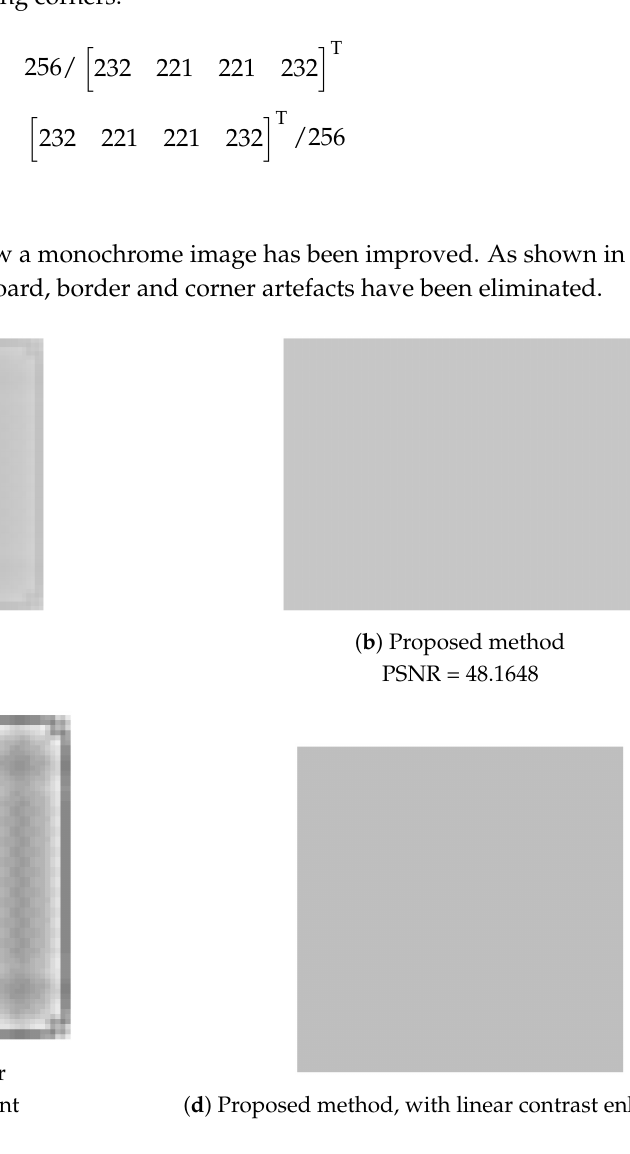
Figure 23. Testing with a monochrome image. After improvement, chequerboard, border and corner artefacts have been